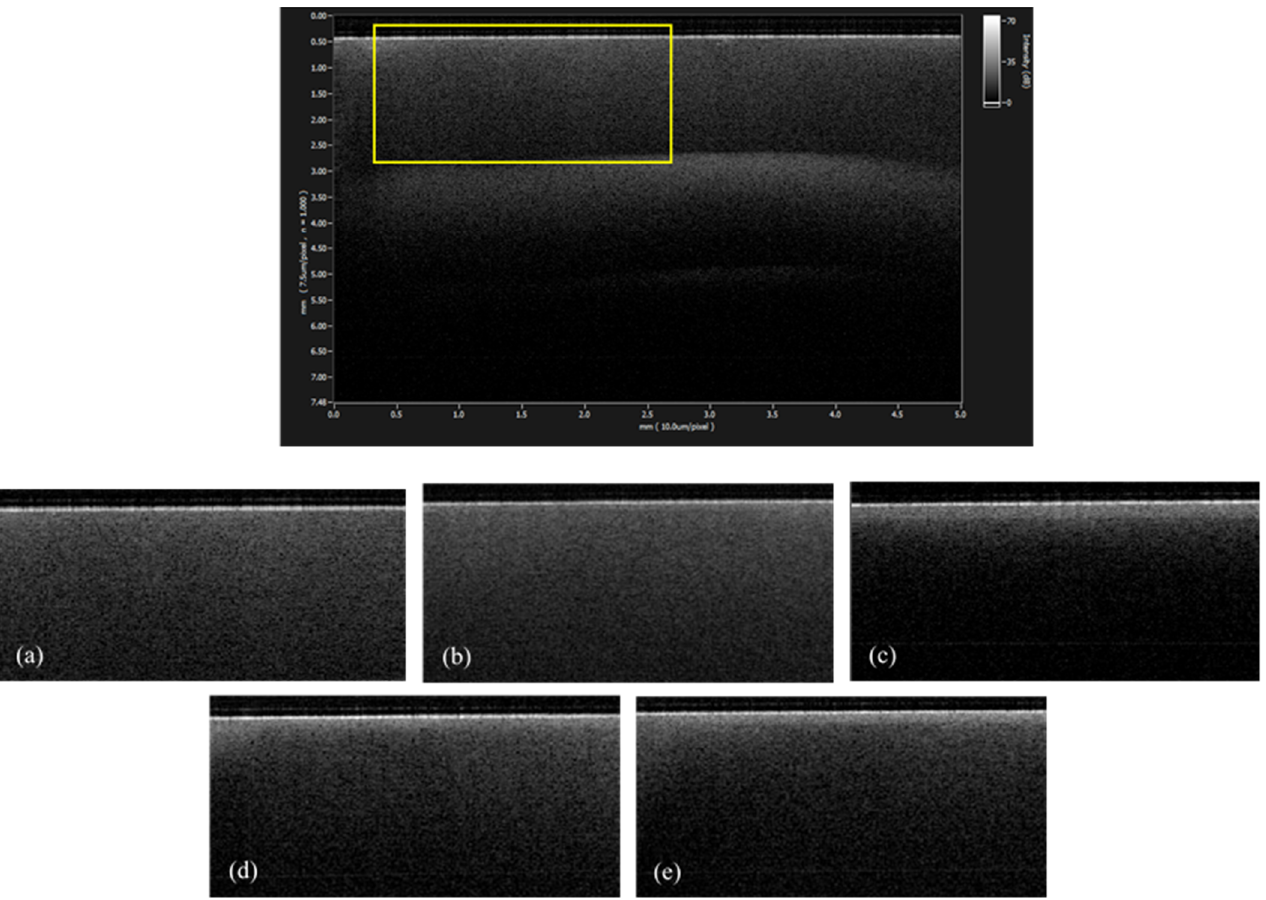
Figure 3. Representative SS-OCT images in each group. The whole image (1) and part surrounded by yellow, including the dentin surface (2). In each group, (2) was adopted as an evaluation target. The dentin surface of the group 3 ( c ) appeared clearly distinct from that of the group 1 ( a ). The images of the group 4 ( d ) and group 5 ( e ) showed similar brightness of the dentin surface as that of the group 1 ( a ) and group 2 ( b ). ( a ) group 1, sound, ( b ) group 2, de3, ( c ) group 3, de6, ( d ) group 4, CS, and ( e ) group 5, NS.